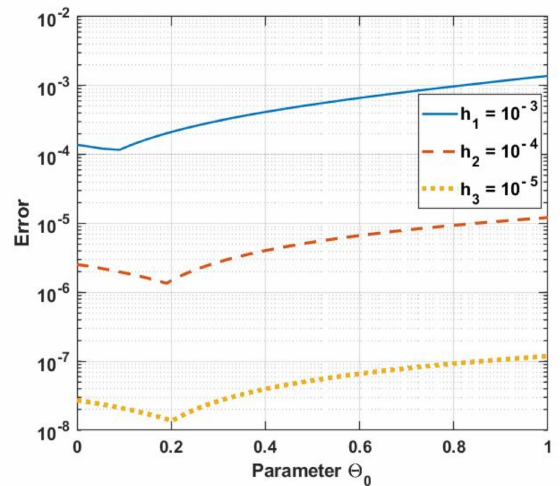
Figure 4. Errors as a function of the parameter θ 0 for the first (moderately stiff) system, in the case of the method L4–5 ( θ , 1 / 2 , C, 1 / 2 , 1 / 2